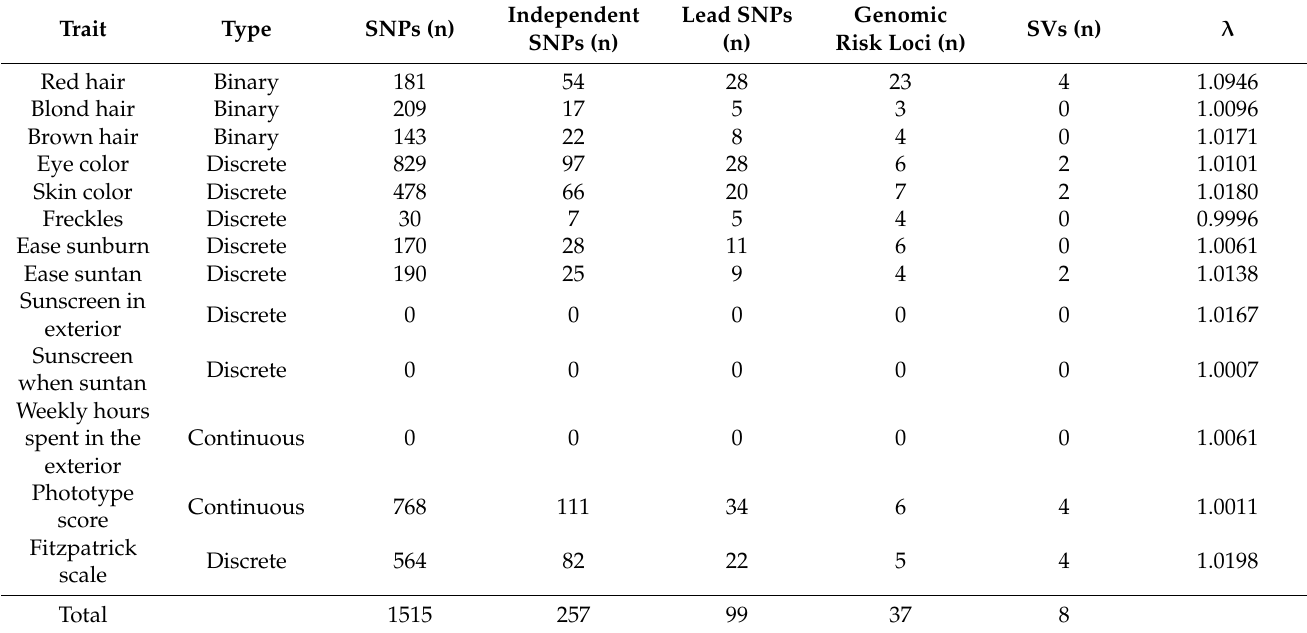
Table 1. Genome-wide association study of pigmentary traits results overview. Overview of the results obtained in the study, summarizing the 13 analyzed traits, type of trait (constitutive, facultative, or built), type of variable (continuous, discrete, or binary), total number of SNPs identified, number of independent SNPs, number of lead SNPs, number of risk loci, and number of structural